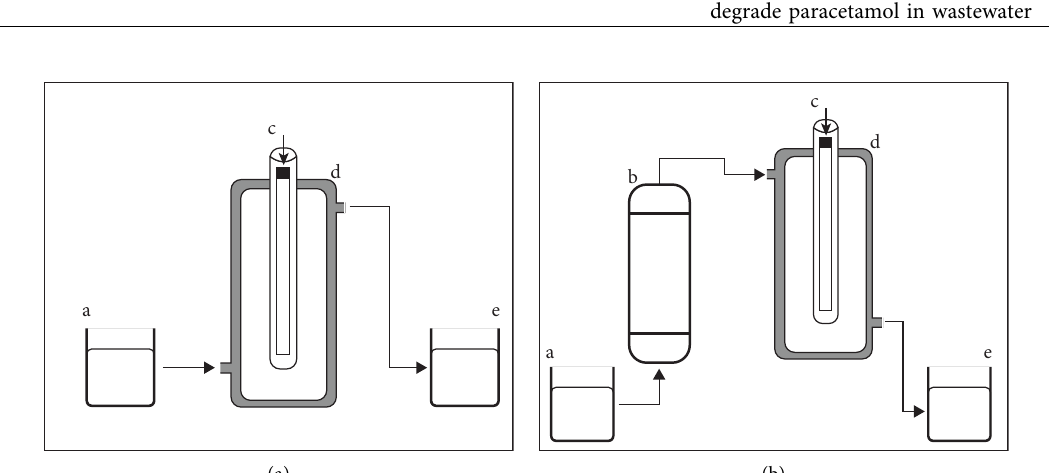
Figure 6: Operation schemes of (a) simultaneous combination (one step) and (b) separate coupling (two steps) of adsorption and photocatalysis (a, wastewater influent; b, adsorption column; c, lamp; d, photocatalytic reactor; and e, wastewater